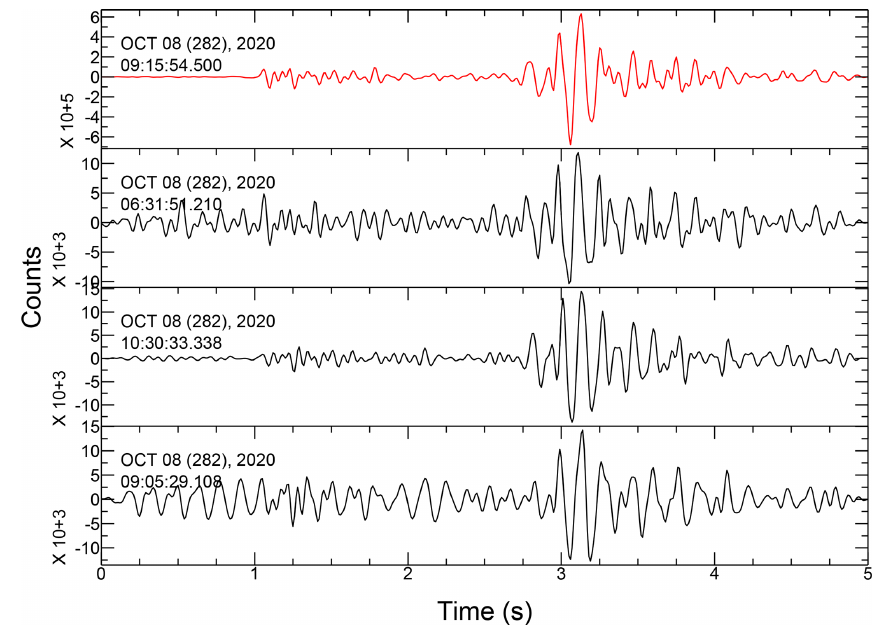
Figure B11. Same as Fig. B10 but for a template located in the central swarm.